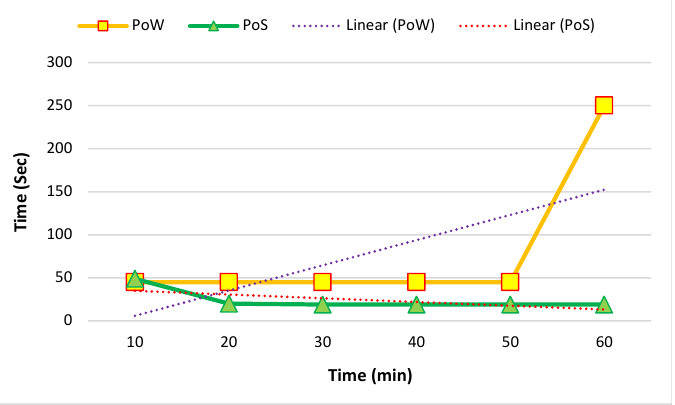
Figure 10. Average mining time in five nodes in one